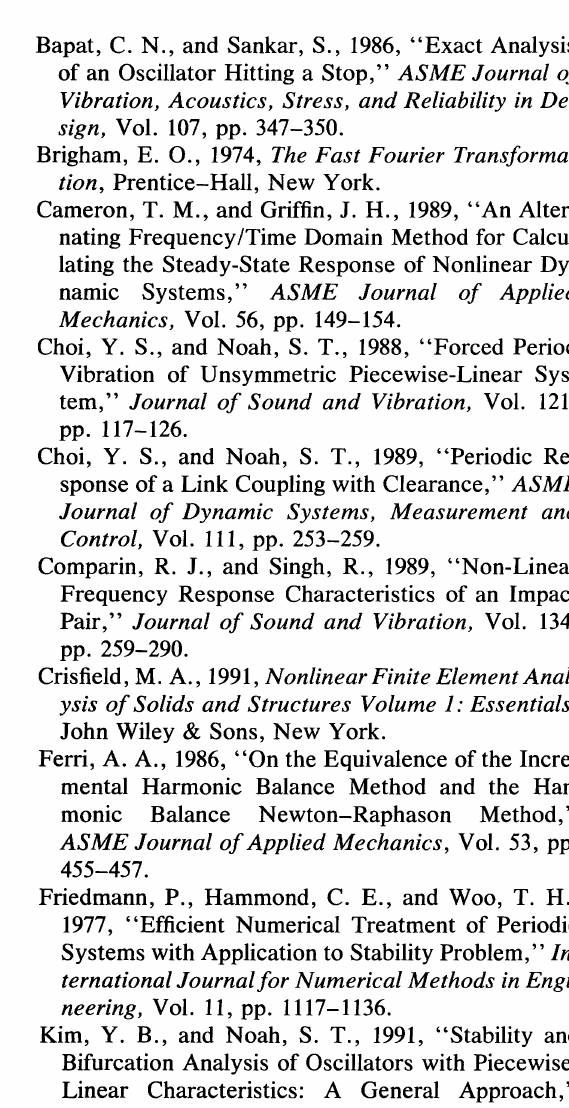
FIGURE 9 Example for coexisted steady-state